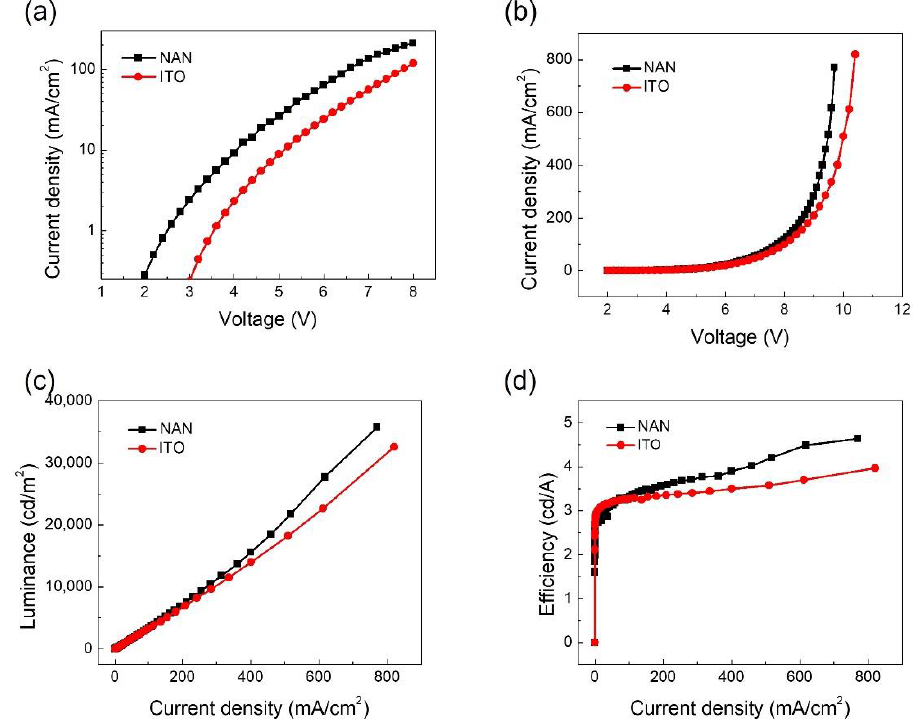
Figure 4. Performance of OLEDs with NAN and ITO anodes. ( a ) Current density – voltage characteristics of hole-only devices. ( b ) Current density – voltage characteristics, ( c ) luminance – current density characteristics, and ( d ) efficiency – current density characteristics.